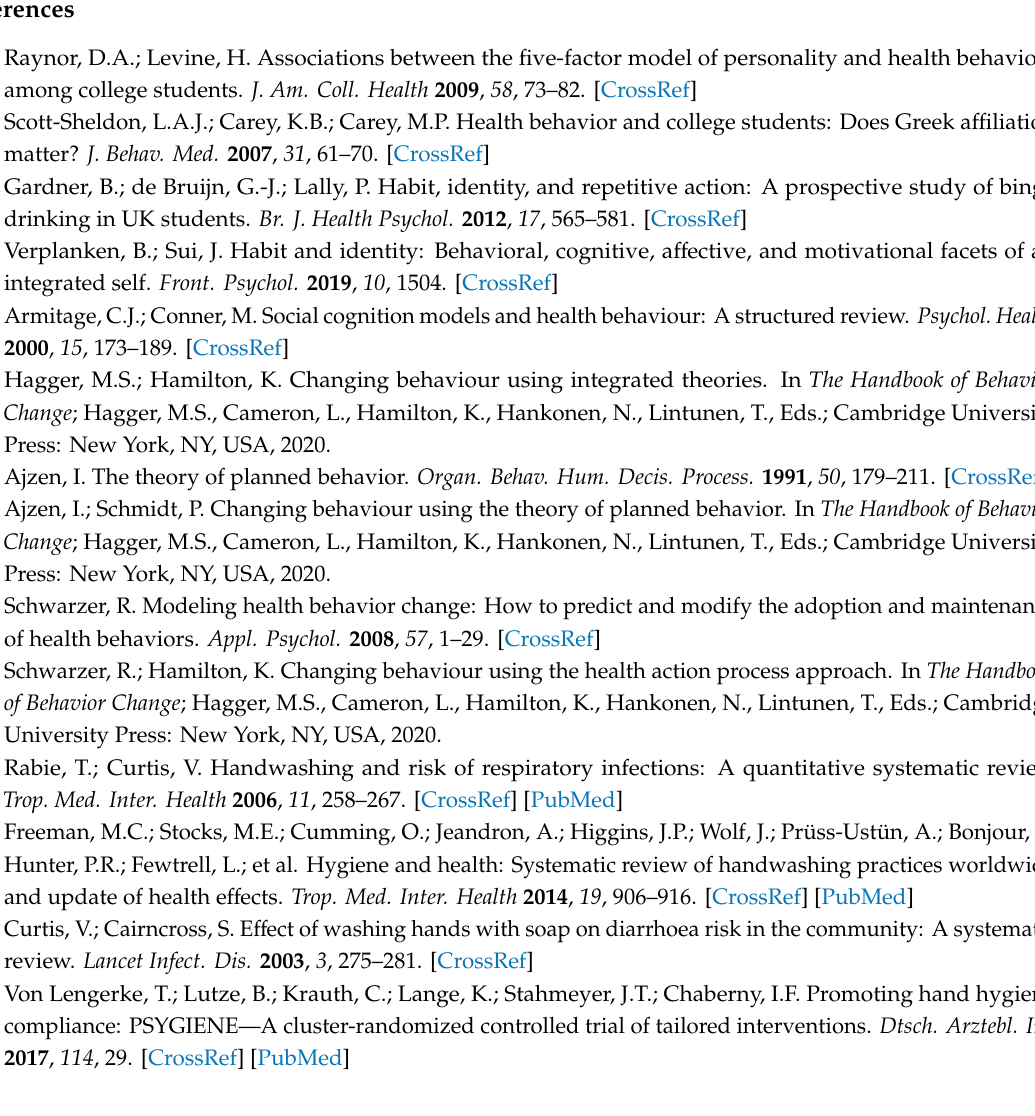
Table S1: Standardized Parameter Estimates for the Direct, Indirect, and Total E ff ects in the Integrated Model of Hand Washing Excluding Past Behavior, Table S2: Standardized Parameter Estimates for the Direct, Indirect, and Total E ff ects in the Integrated Model of Hand Washing Including Past Behavior, Table S3: Standardized Parameter Estimates for the Direct, Indirect, and Total E ff ects in the Integrated Model of Sleep Hygiene Excluding Past Behavior, Table S4: Standardized Parameter Estimates for the Direct, Indirect, and Total E ff ects in the Integrated Model of Sleep Hygiene Including Past